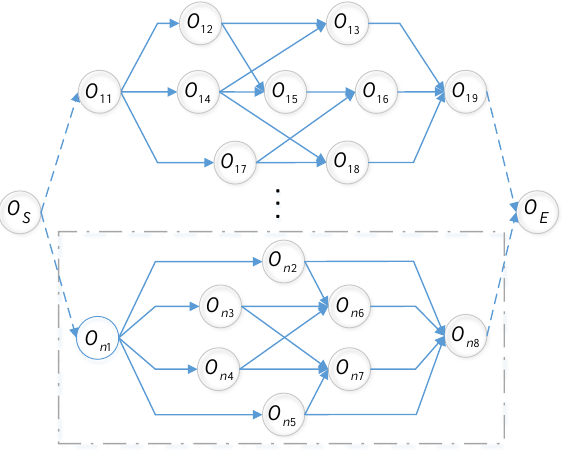
Figure 3. Activity-on-node (AoN) diagram of preventive maintenance operations.